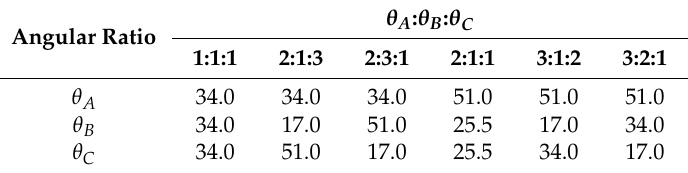
Table 1. In the case of stepped air gap, angular ratio of three portion of θ A , θ B , and θ C in degrees.